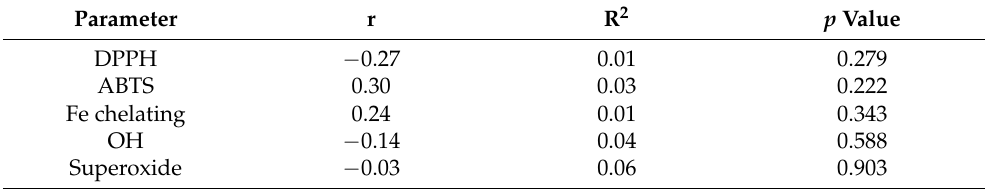
Table 3. Linear correlations between antioxidant activity and concentration of hydroxyl groups